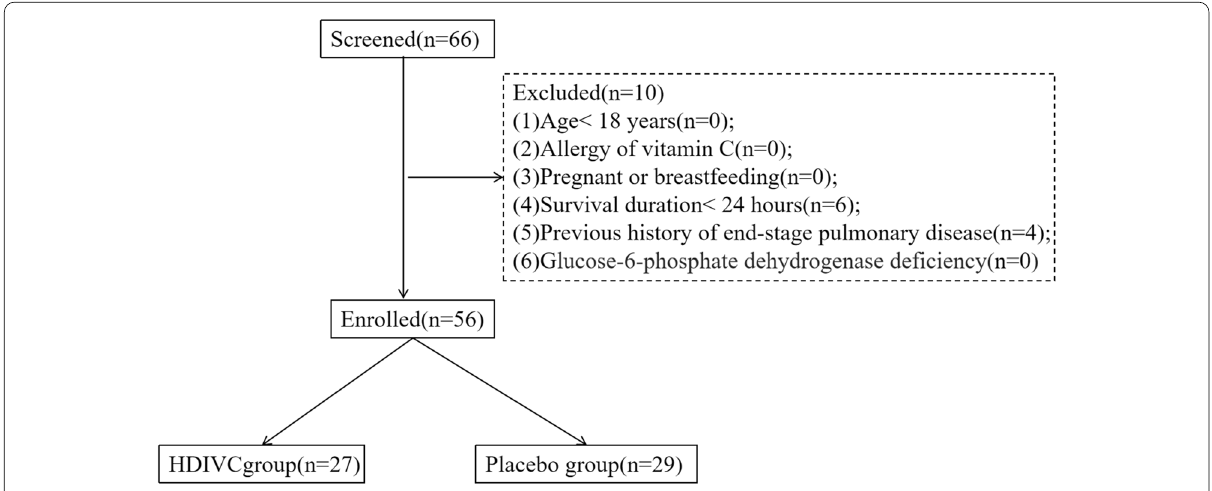
Fig. 1 Flowchart of patients. HDIVC high-dose intravenous vitamin